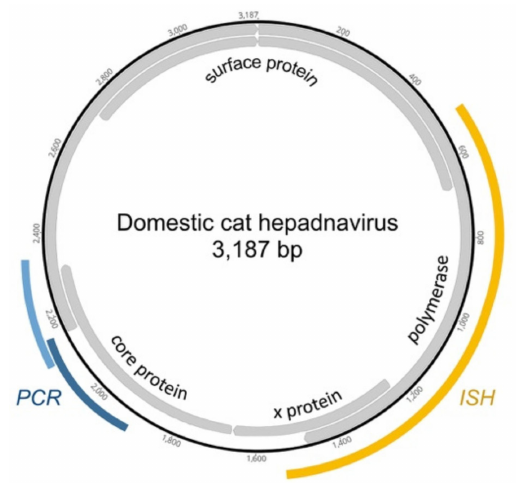
Figure 1. Domestic cat hepadnavirus genome. There are four ORFs. PCR probes used for this study (blue) are partially overlapping and span the junction between the core and polymerase genes. The core and polymerase genes in the ortholog hepatitis B virus (HBV) are required for replication. The ISH probe V-FeHepadnavirus (yellow) is a 20 ZZ paired probe set hybridizing to target DNA or transcript of the X and polymerase